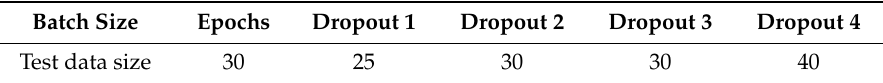
Figure 13. ( a ) An average loss function graph of two FOP-CNN case models when motor loading condition is used (Case A), and when it is not (Case B); ( b ) an average classification graph of two FOP-CNN case models when motor loading condition is used (Case A), and when it is not (Case B). Table 2. FOP-CNN Hyper-parameters.